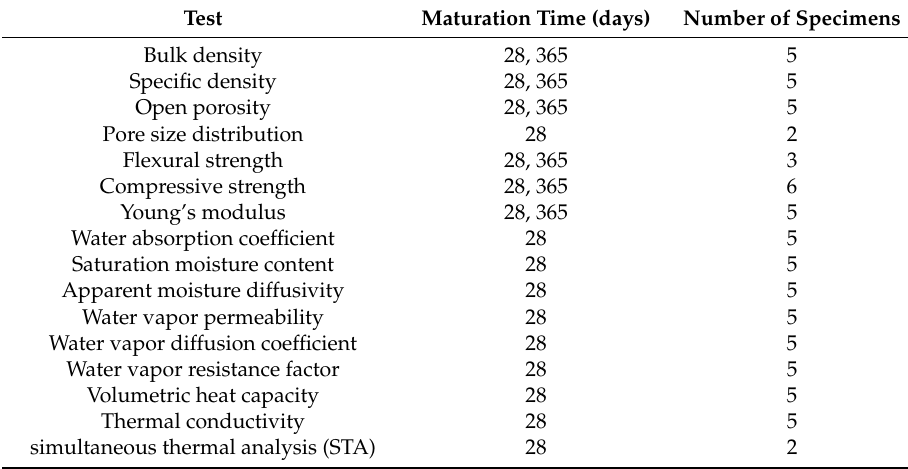
Table 2. Overview of the experimental campaign conducted for hardened mortar